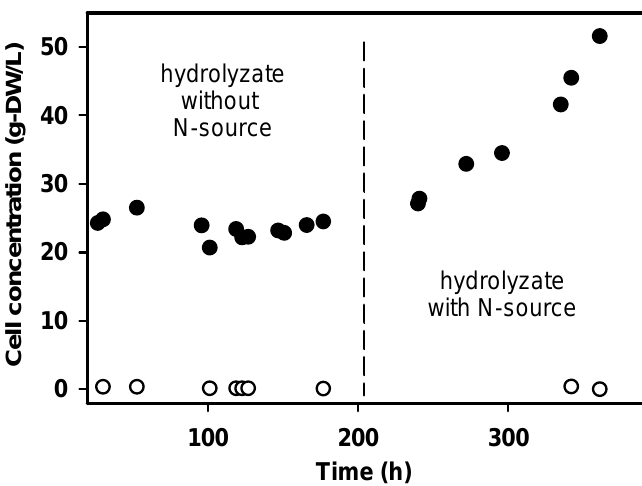
Figure 4 . The trend of cell concentration inside the bioreactor ( (cid:1) ) and in the effluent of the settler ( (cid:1) ) in anaerobic continuous cultivation of the hydrolyzate with the flocculating yeast. The dashed line distinguishes when the nitrogen source was present or absent in the defined